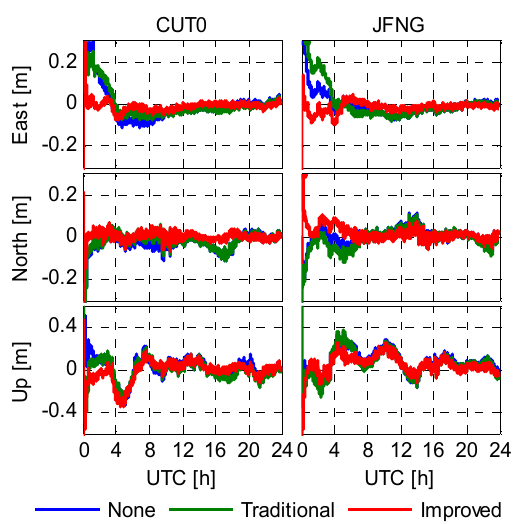
Figure 9. Epoch-wise PPP solutions of CUT0 and JFNG (DoY 047/2014).